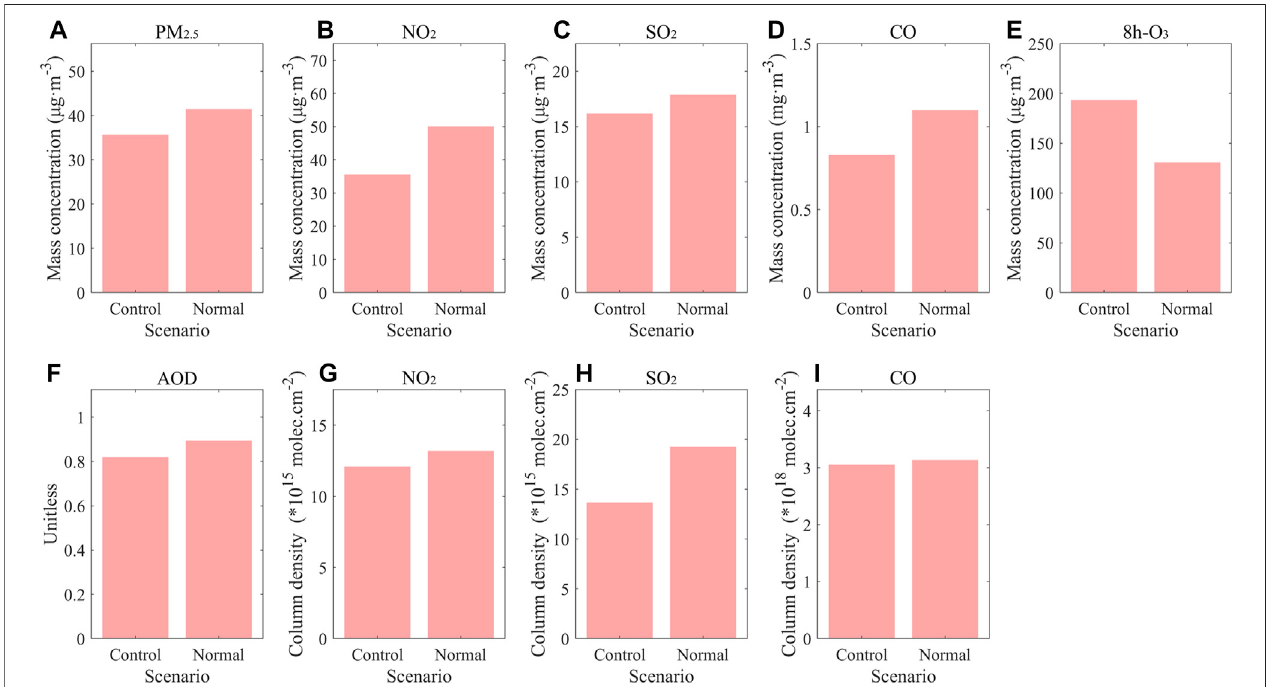
FIGURE 3 | The comparison of during control period vs. normal period (spring) for surface observations (A – C) and satellite retrievals (F – I) .